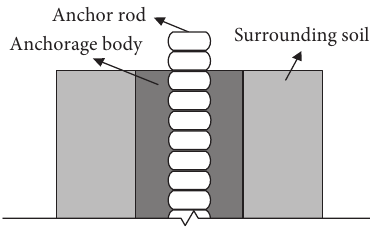
Figure 1: Component of the antifloating anchor system.